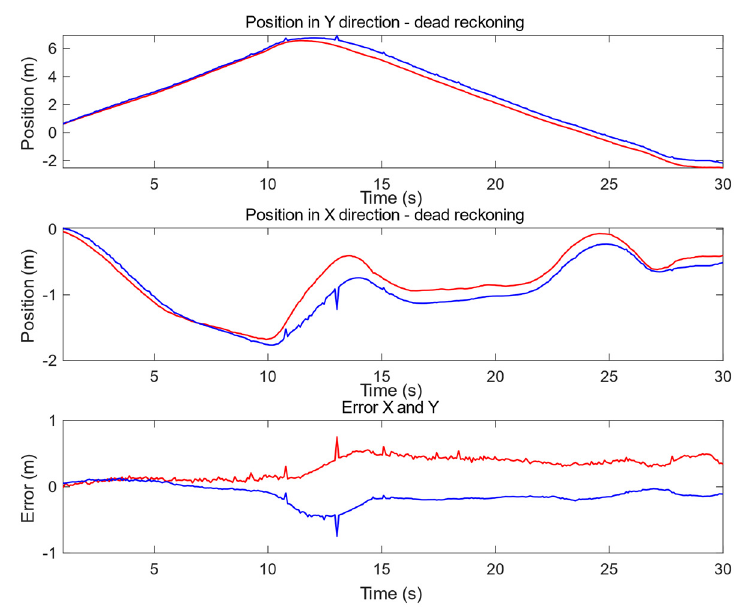
Figure 15. Plot present positioning results and error from dead reckoning in comparison to SLAM in the environment “corridor part A.” DR (blue) displacement with respect to SLAM (red): ( top ) vertical y position, ( middle ) horizontal X position, ( bottom ) DR error—displacement vector in horizontal (blue) and vertical (red) axes.